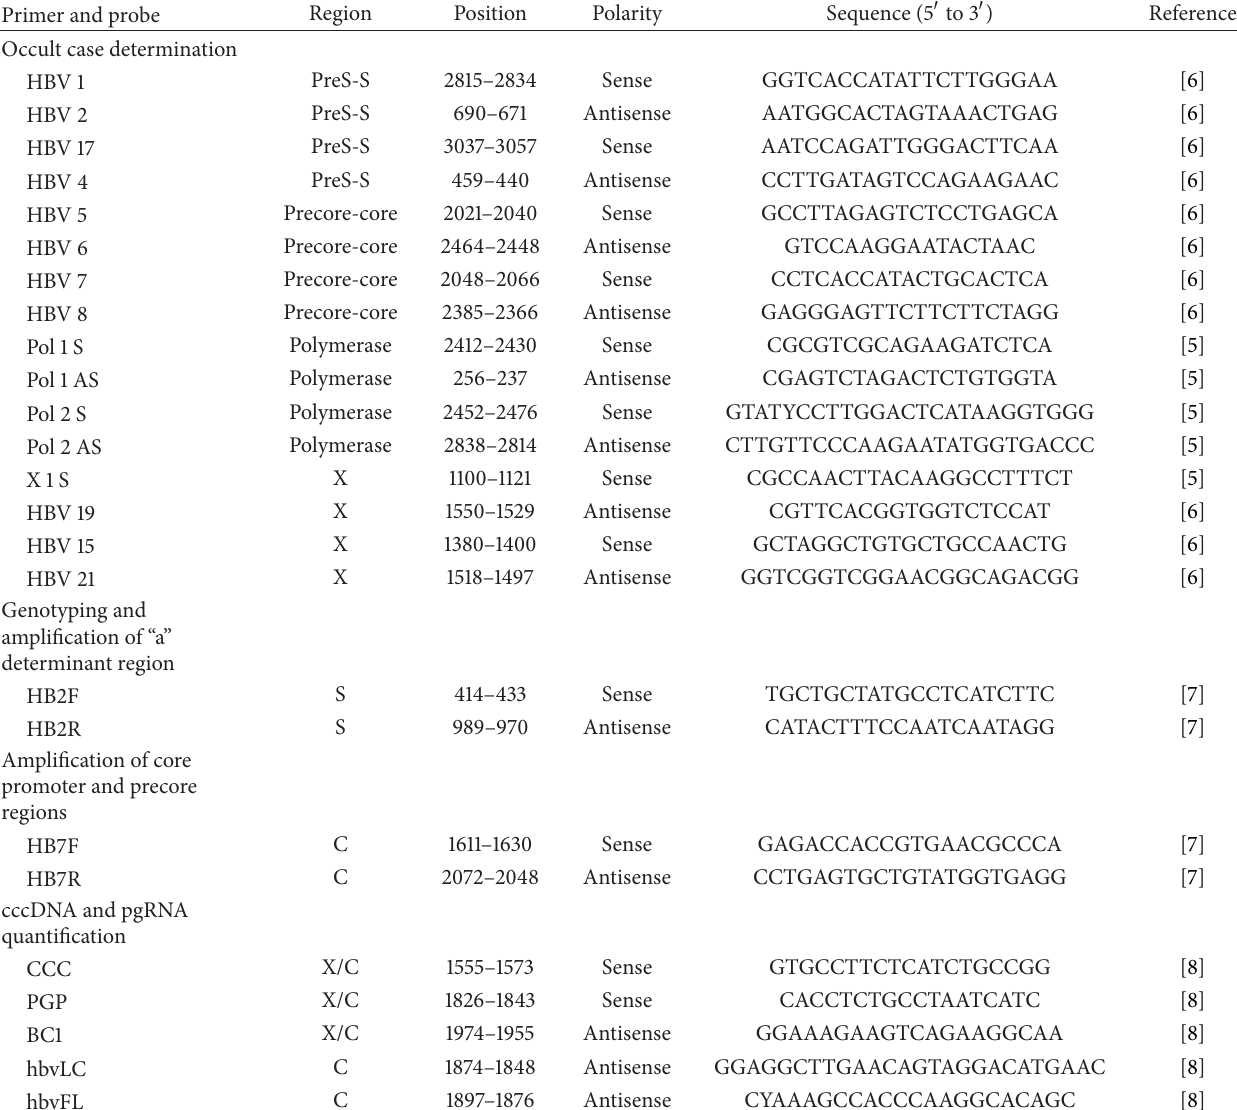
Table 1: Sequences and positions of primers and probes used in this